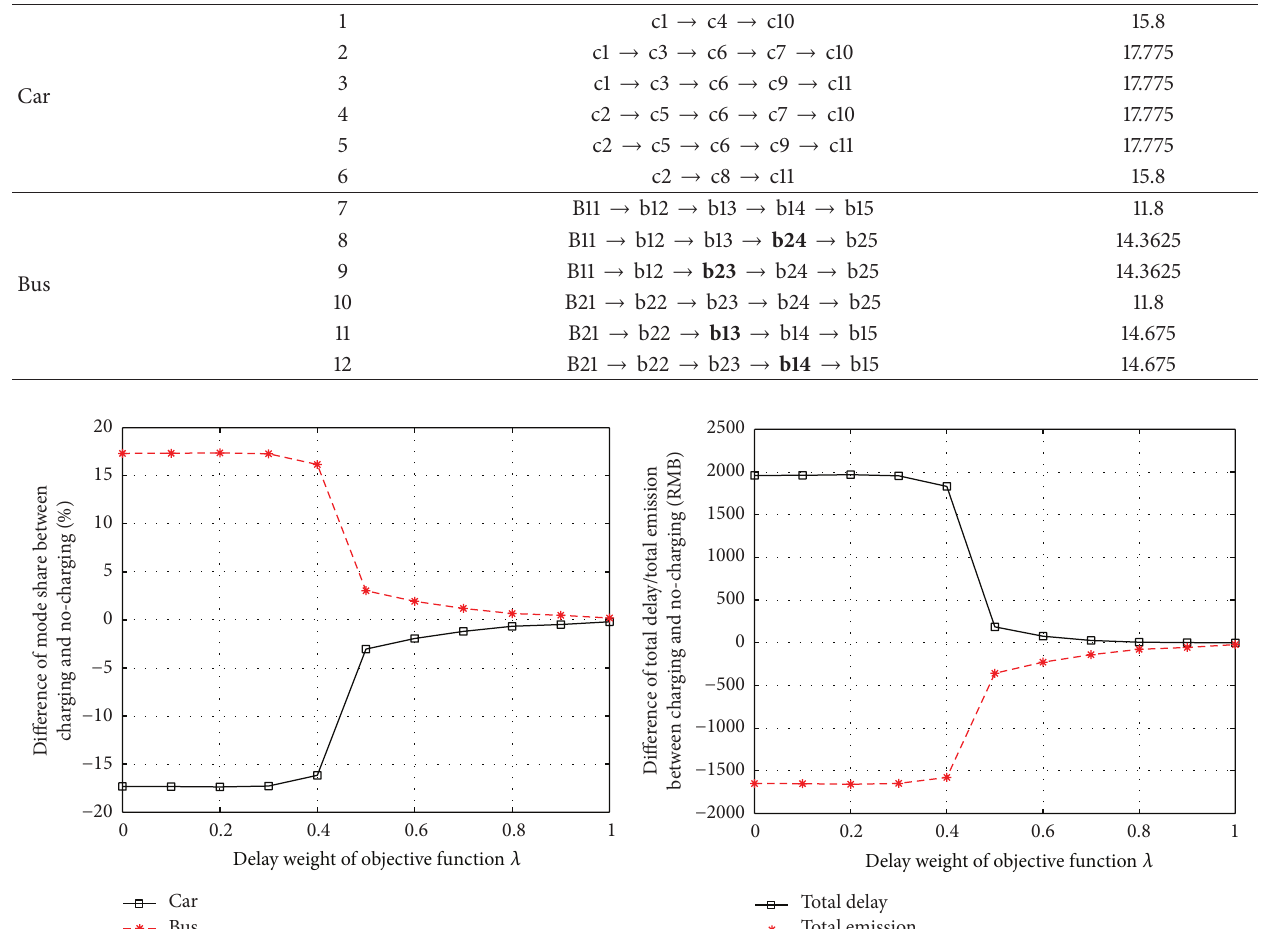
Table 6: Information of the effective paths.